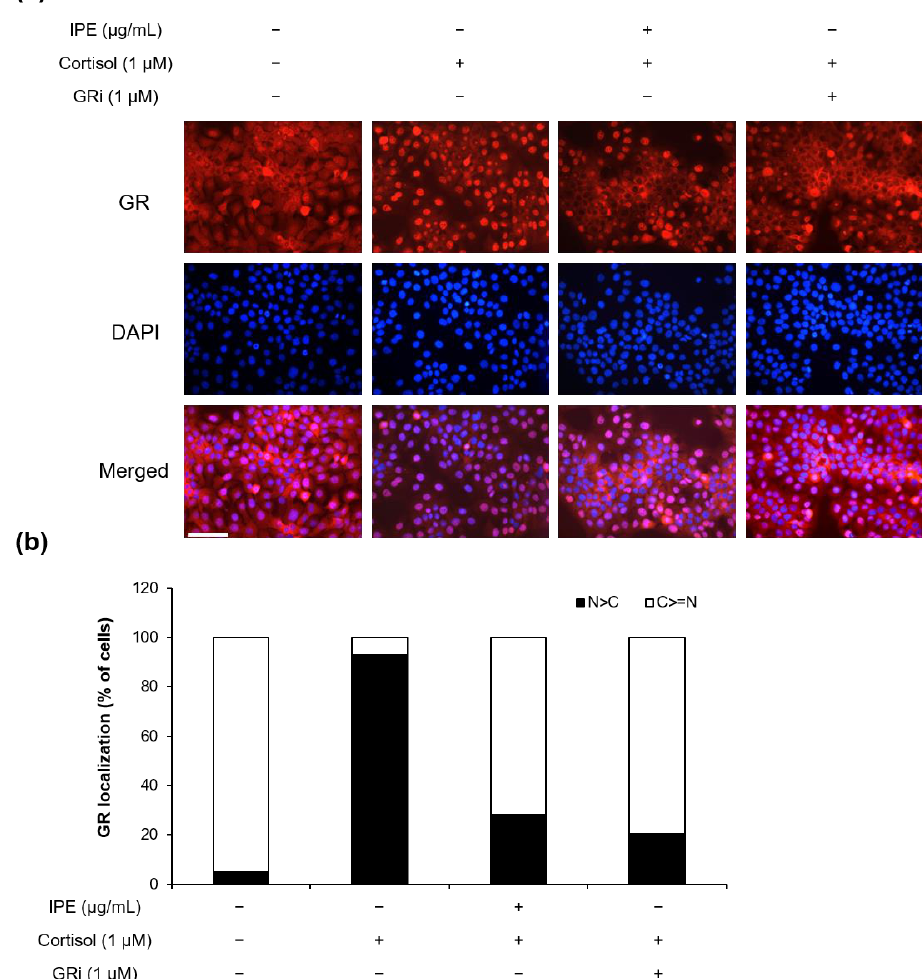
Figure 4. Inhibitory effect of IPE on cortisol-induced glucocorticoid receptor (GR) nuclear translocation. ( a ) Immunofluorescence analysis for GR localization in HaCaT cells. Cells were incubated in serum-free DMEM with IPE (100 µ g/mL) or GR inhibitor (mifepristone, 1 µ M) for 1 h before exposure to cortisol (1 µ M). After 1 h of stimulation, the cells were fixed in 4% formaldehyde, permeabilized with 0.1% Triton X-100, and stained with antibody against the GR (red). DAPI (blue) was used for nuclear staining. Scale bar = 100 nm. ( b ) Quantification of GR subcellular distribution. Predominantly nuclear or cytoplasmic GR localization was analyzed using merged images with DAPI, and the number of cells according to GR location is expressed as a percentage. N, nucleus; C, cytoplasm; GRi, GR inhibitor.